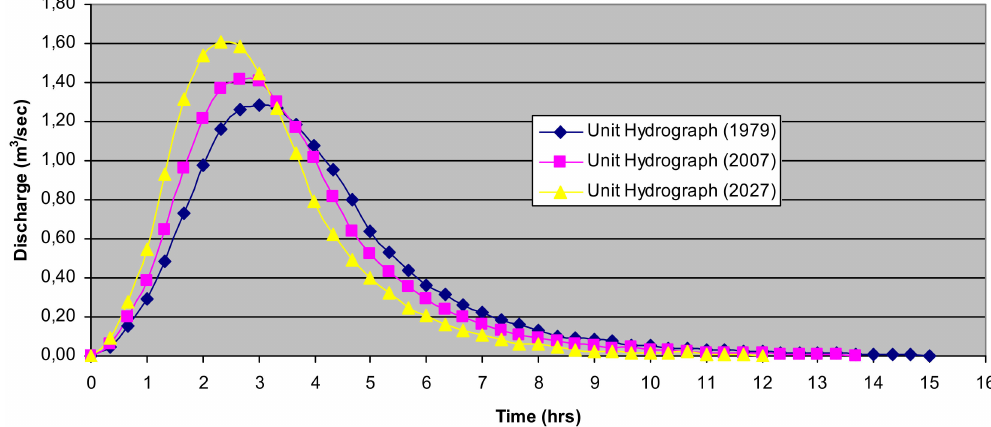
Figure 7. The unit hydrograph response to urban